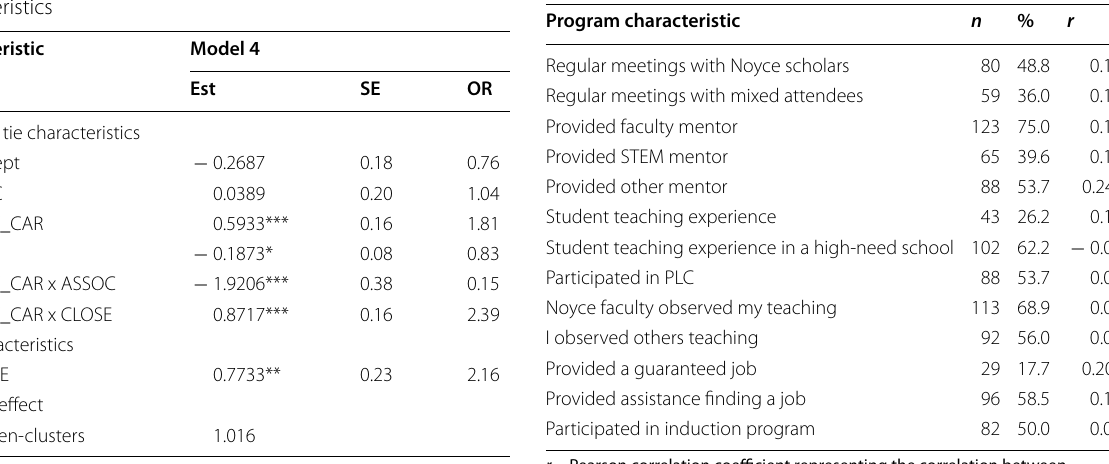
Table 5 Descriptive statistics for Noyce program characteristics